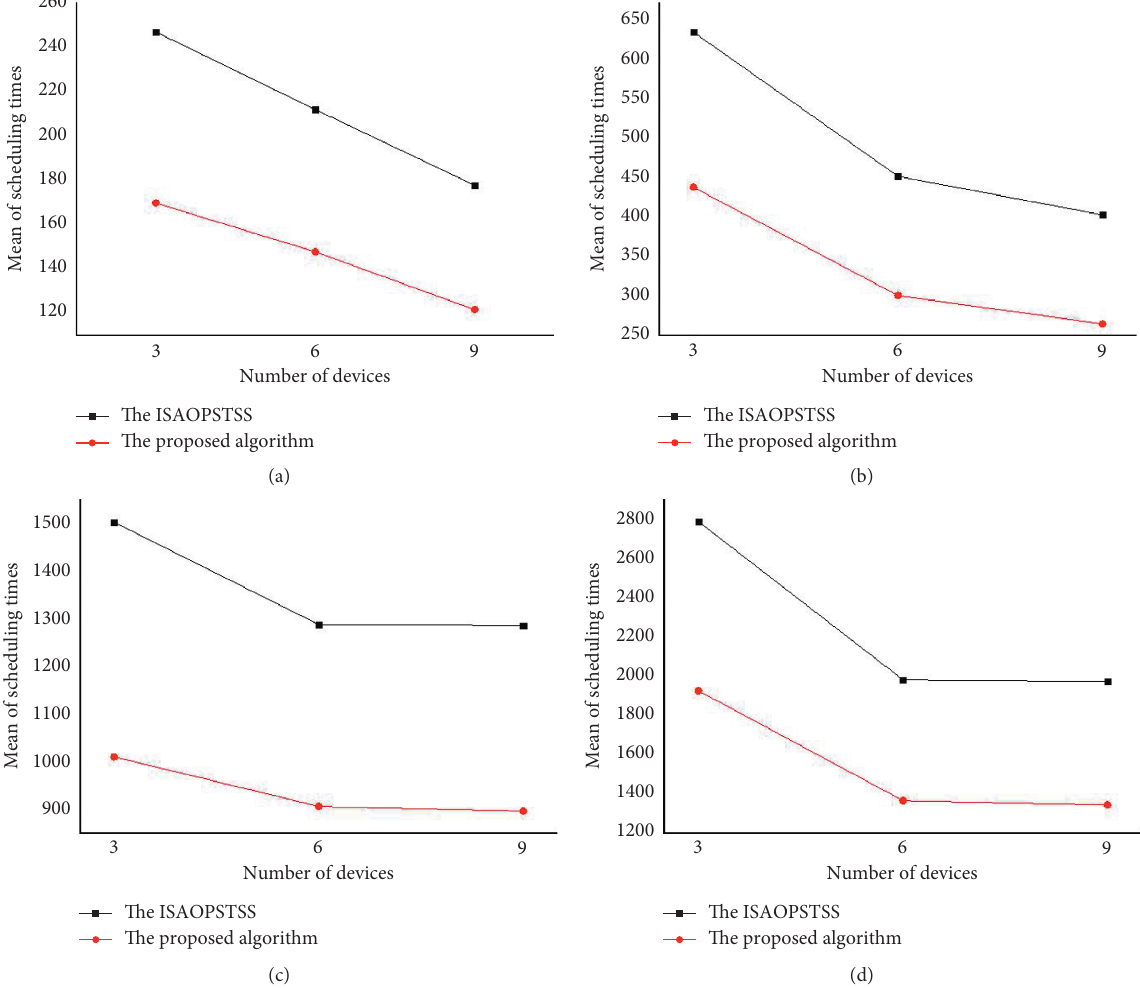
Figure 9: The comparison chart of the average scheduling times when the total number of processes is 30, 50, 80, and 100, respectively. (a) Comparison chart of mean scheduling times when the number of processes is 30. (b) Comparison chart of mean scheduling times when the number of processes is 50. (c) Comparison chart of mean scheduling times when the number of processes is 80. (d) Comparison chart of mean scheduling times when the number of processes is 100.